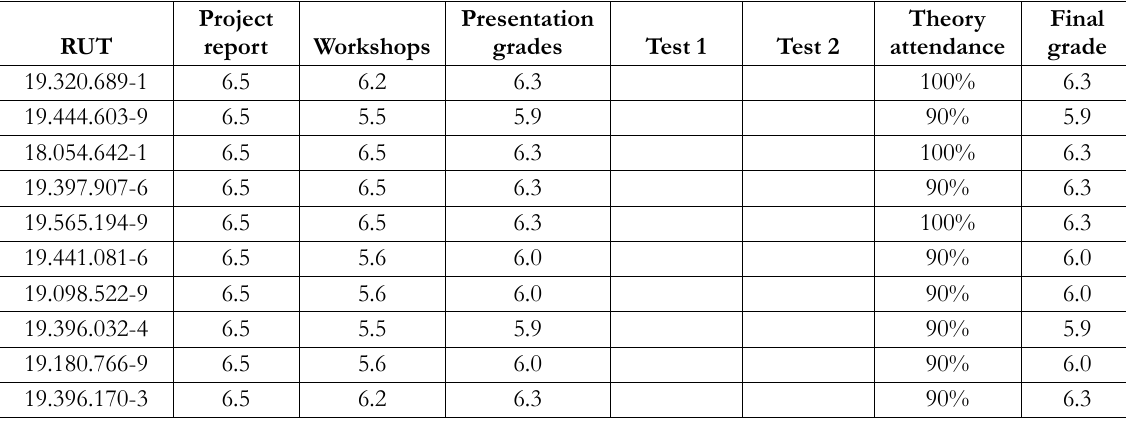
Table 1. Record of grades (Grades system Universidad de Antofagasta)